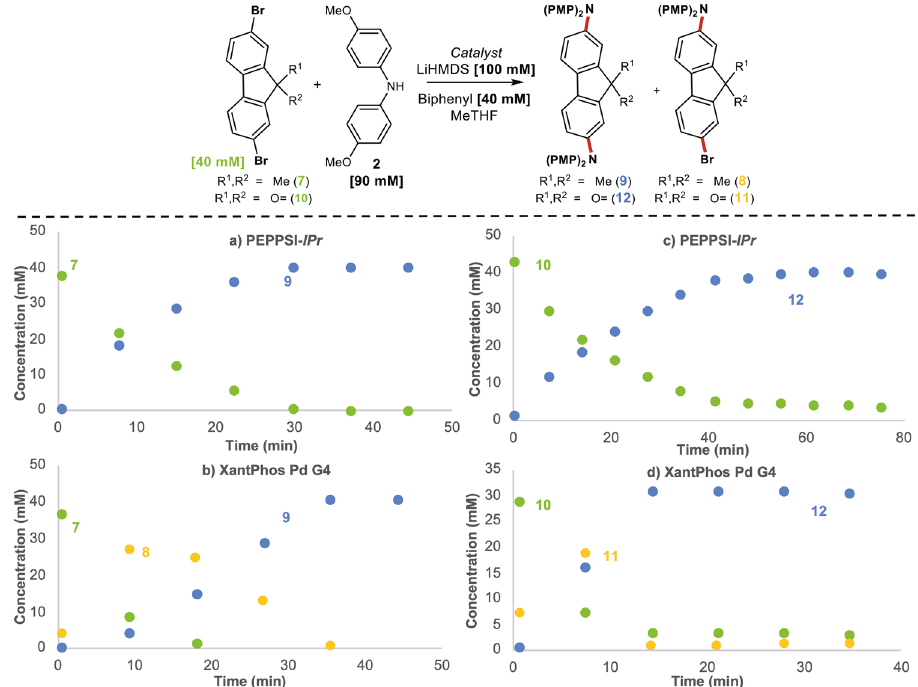
Fig. 8 Time course data on alternative dibrominated substrates. a Time course data for coupling of 7 with PEPPSI-IPr. b Time course data for coupling of 7 with XantPhos Pd G4. c Time course data for coupling of 10 with PEPPSI-IPr. d Time course data for coupling of 10 with XantPhos Pd